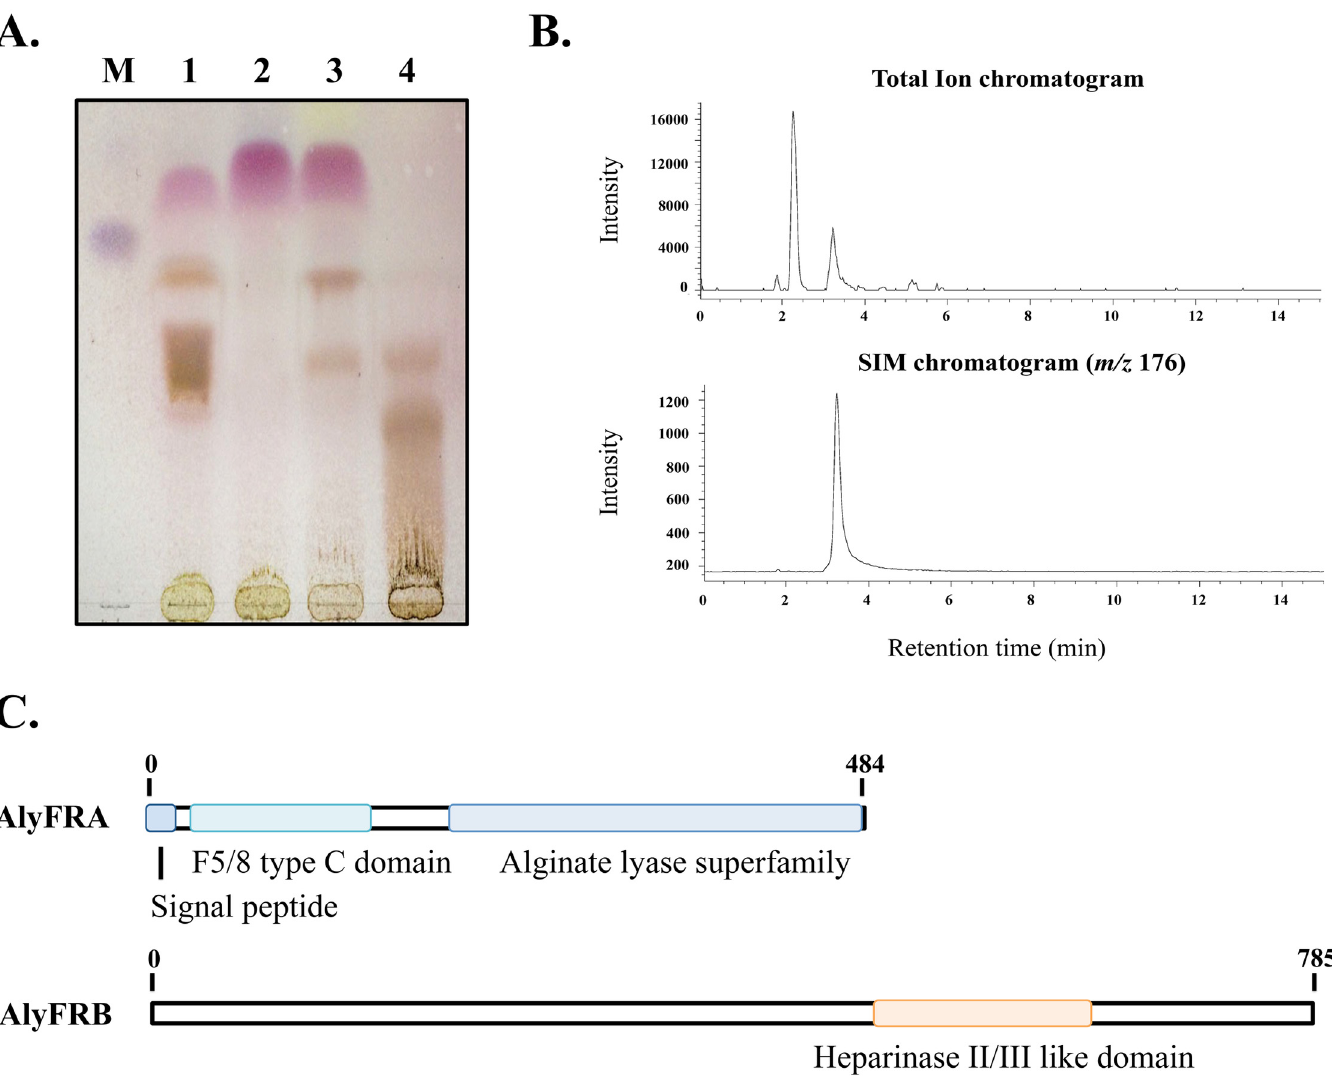
Fig 3. Alginate degrading features of AlyFRA and AlyFRB. a. TLC analysis of alginate-degraded products upon treatment with the respective enzymes. M: Hydrolyzed sodium alginate, 1:AlyFRA, 2:AlyFRB, 3: Alg17C ( Saccharophagus degradans ), 4: Commercial alginate lyase. b. TIC and SIM chromatograms for the identification of DEH within the degraded products of AlyFRB. Peaks from both the TIC and SIM chromatograms at the retention time of 3.2 min indicates DEH. c. Conserved domains identified within AlyFRA and AlyFRB. The conserved domains were determined by using the NCBI Conserved Domain Search